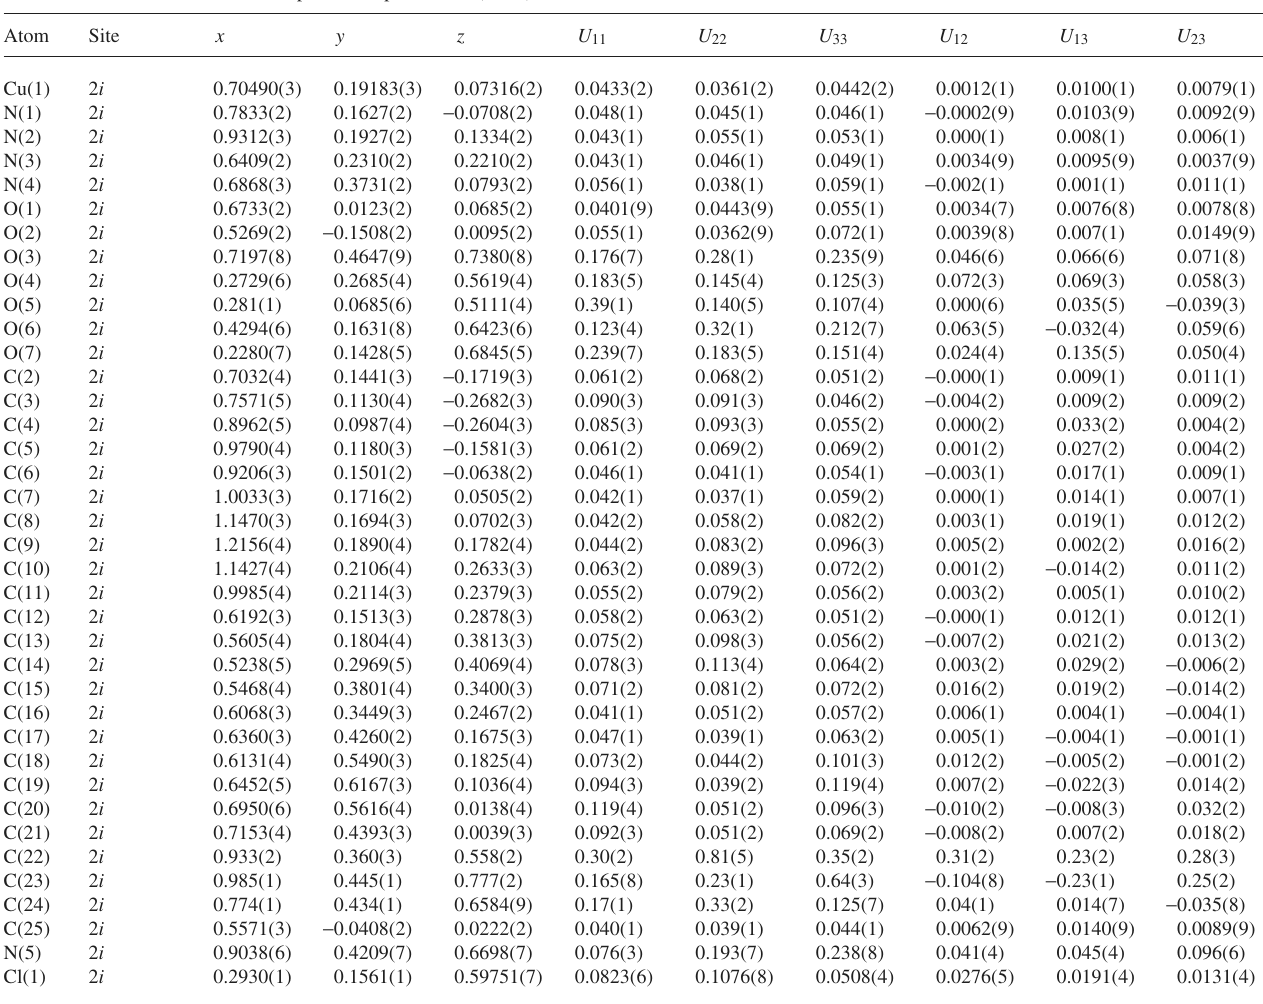
Table 3. Atomic coordinates and displacement parameters (in Å 2 )